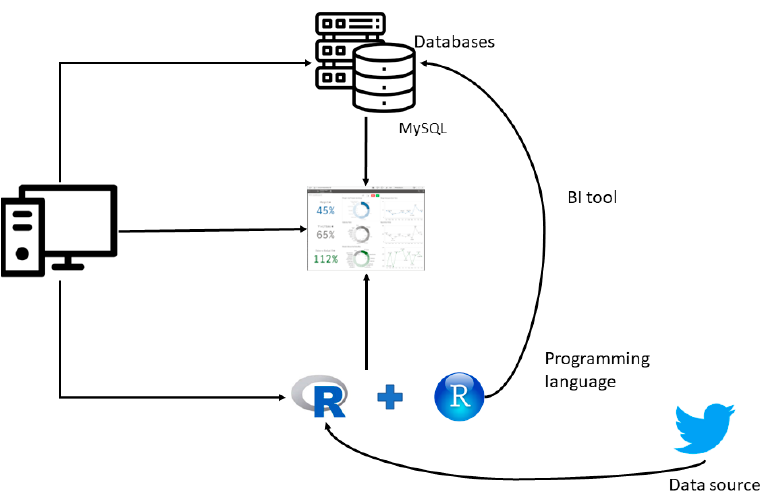
Figure 2. Method for sentiment analysis of a social network with integration with a database and information visualization tools.